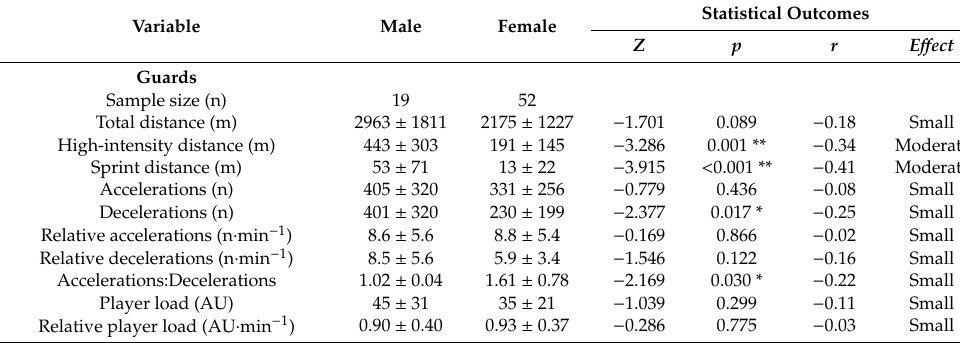
Table 3. The external loads (mean ± standard deviation) encountered by elite, junior male and female players according to playing position during